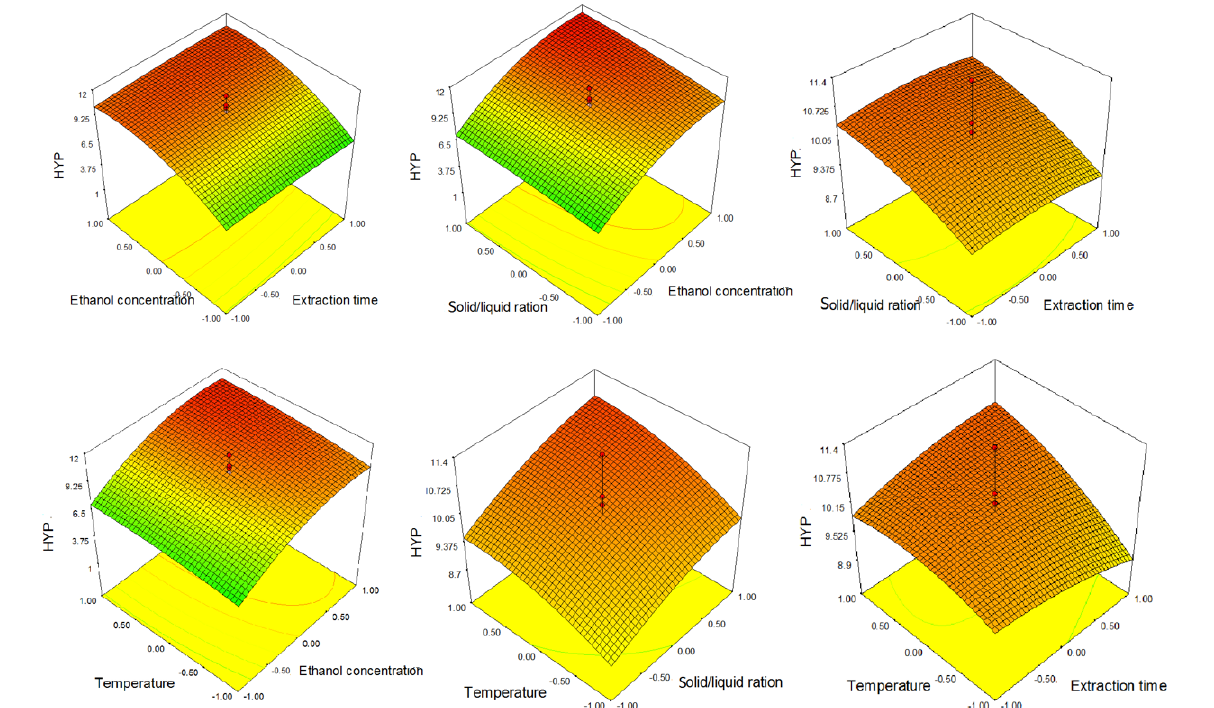
Figure 2. Response surfaces showing the combined effect of parameters on 4 (cid:48) - O -methylhypolaetin-7- O -[6 (cid:48)(cid:48)(cid:48) - O -acetyl- β - D - allopyranosyl (1 → 2)]- β - D -glucopyranoside